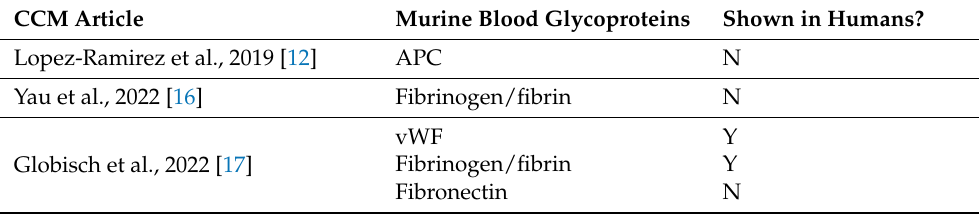
Table 1. Blood glycoproteins related to the coagulation cascade identified in CCM. CCM Article Murine Blood Glycoproteins Shown in